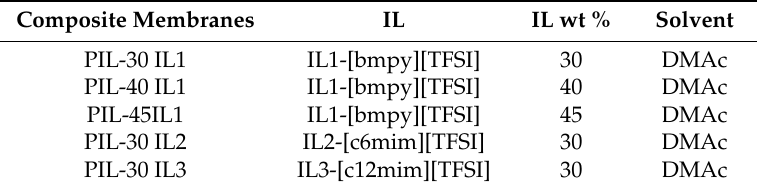
Table 1. Composition of the prepared PIL-IL composite membranes (PIL refers to the PIL containing TFSI as counter